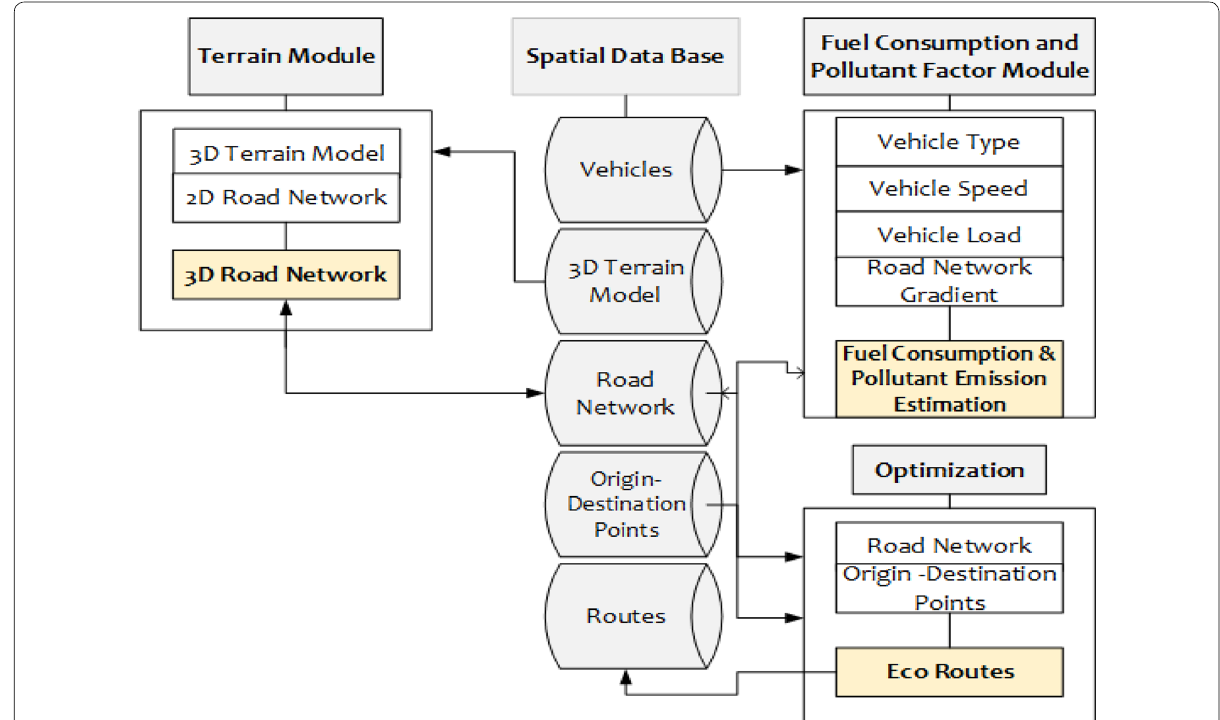
Fig. 4 Structure of the developed model showing spatial data base and its modules